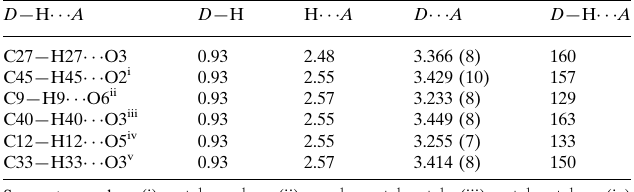
Hydrogen-bond geometry (A˚ , (cid:2)